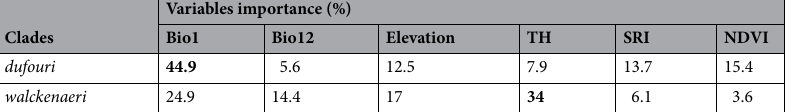
Variables importance